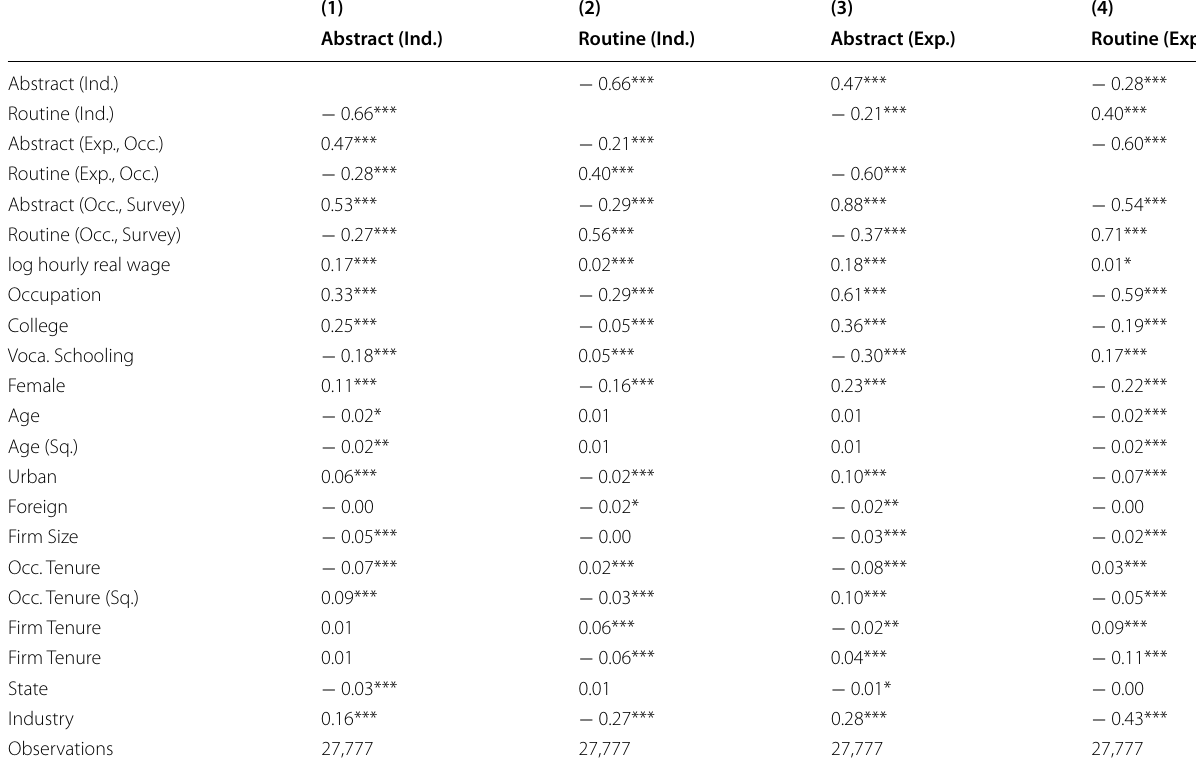
Table 7 Correlation between individual-level tasks & other covariates